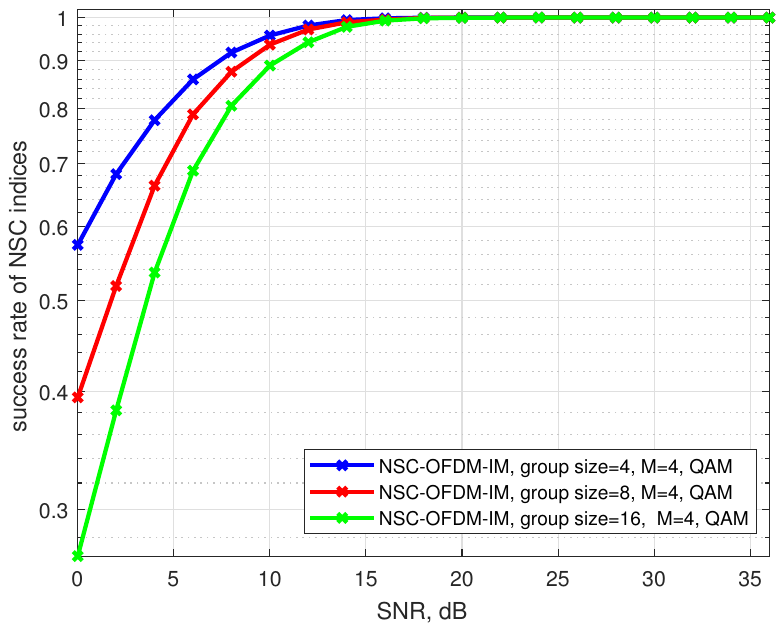
Figure 11. Succession rate of the null carrier indices for the proposed NSC-OFDM-IM